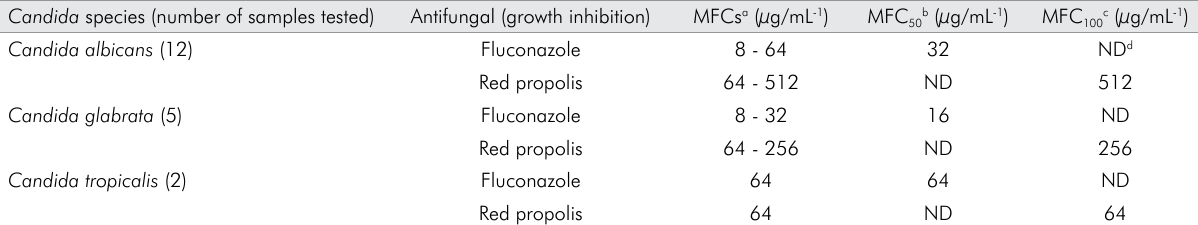
Table 2. Mean results of fungicidal activity of fluconazole and red propolis alcoholic extract against Candida species isolated from cases of chronic